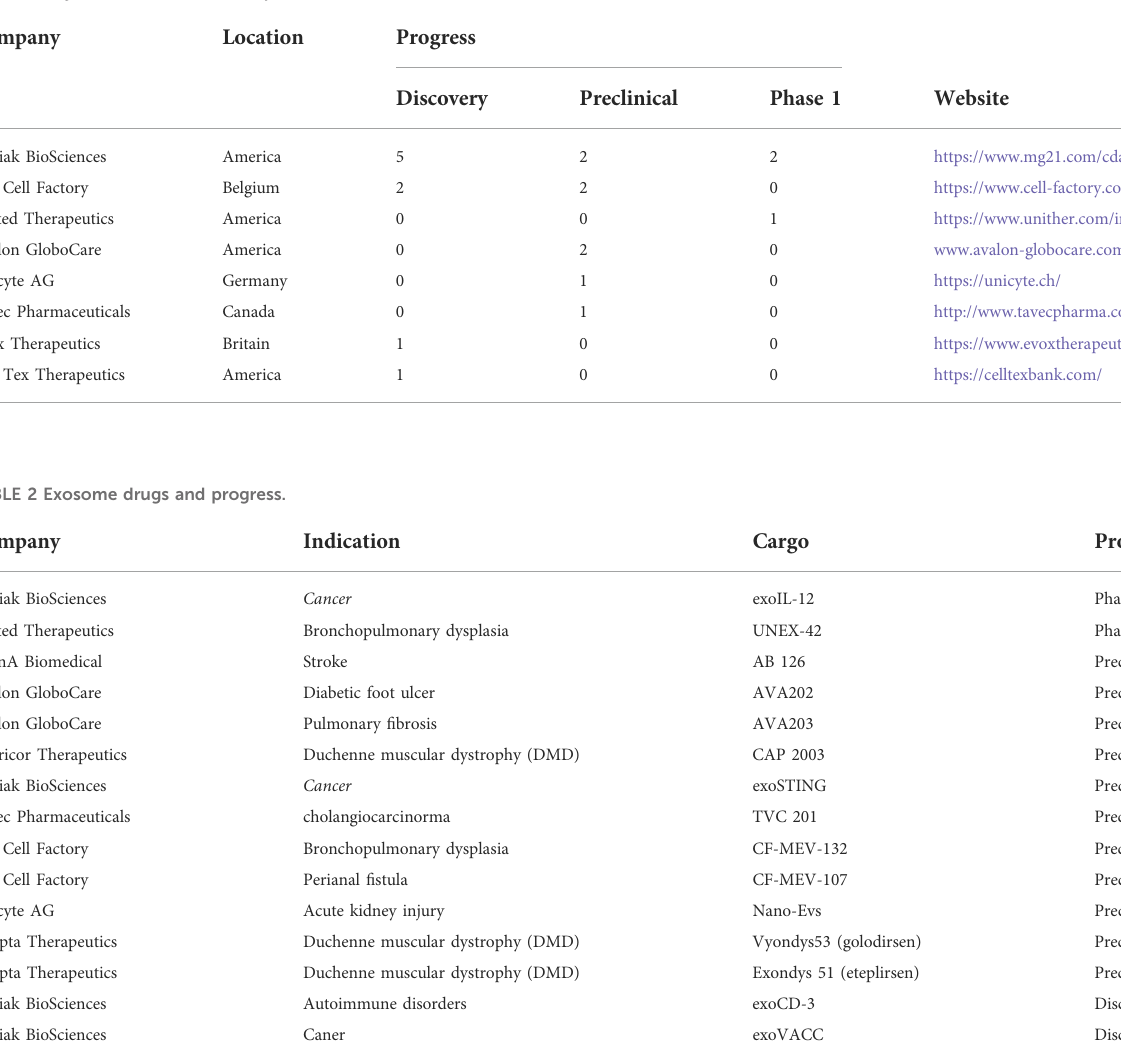
TABLE 1 Major exosome R & D companies.